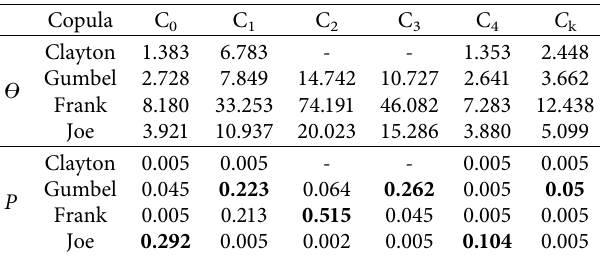
Table 5: Parameter estimation and goodness-of-fit test of copula